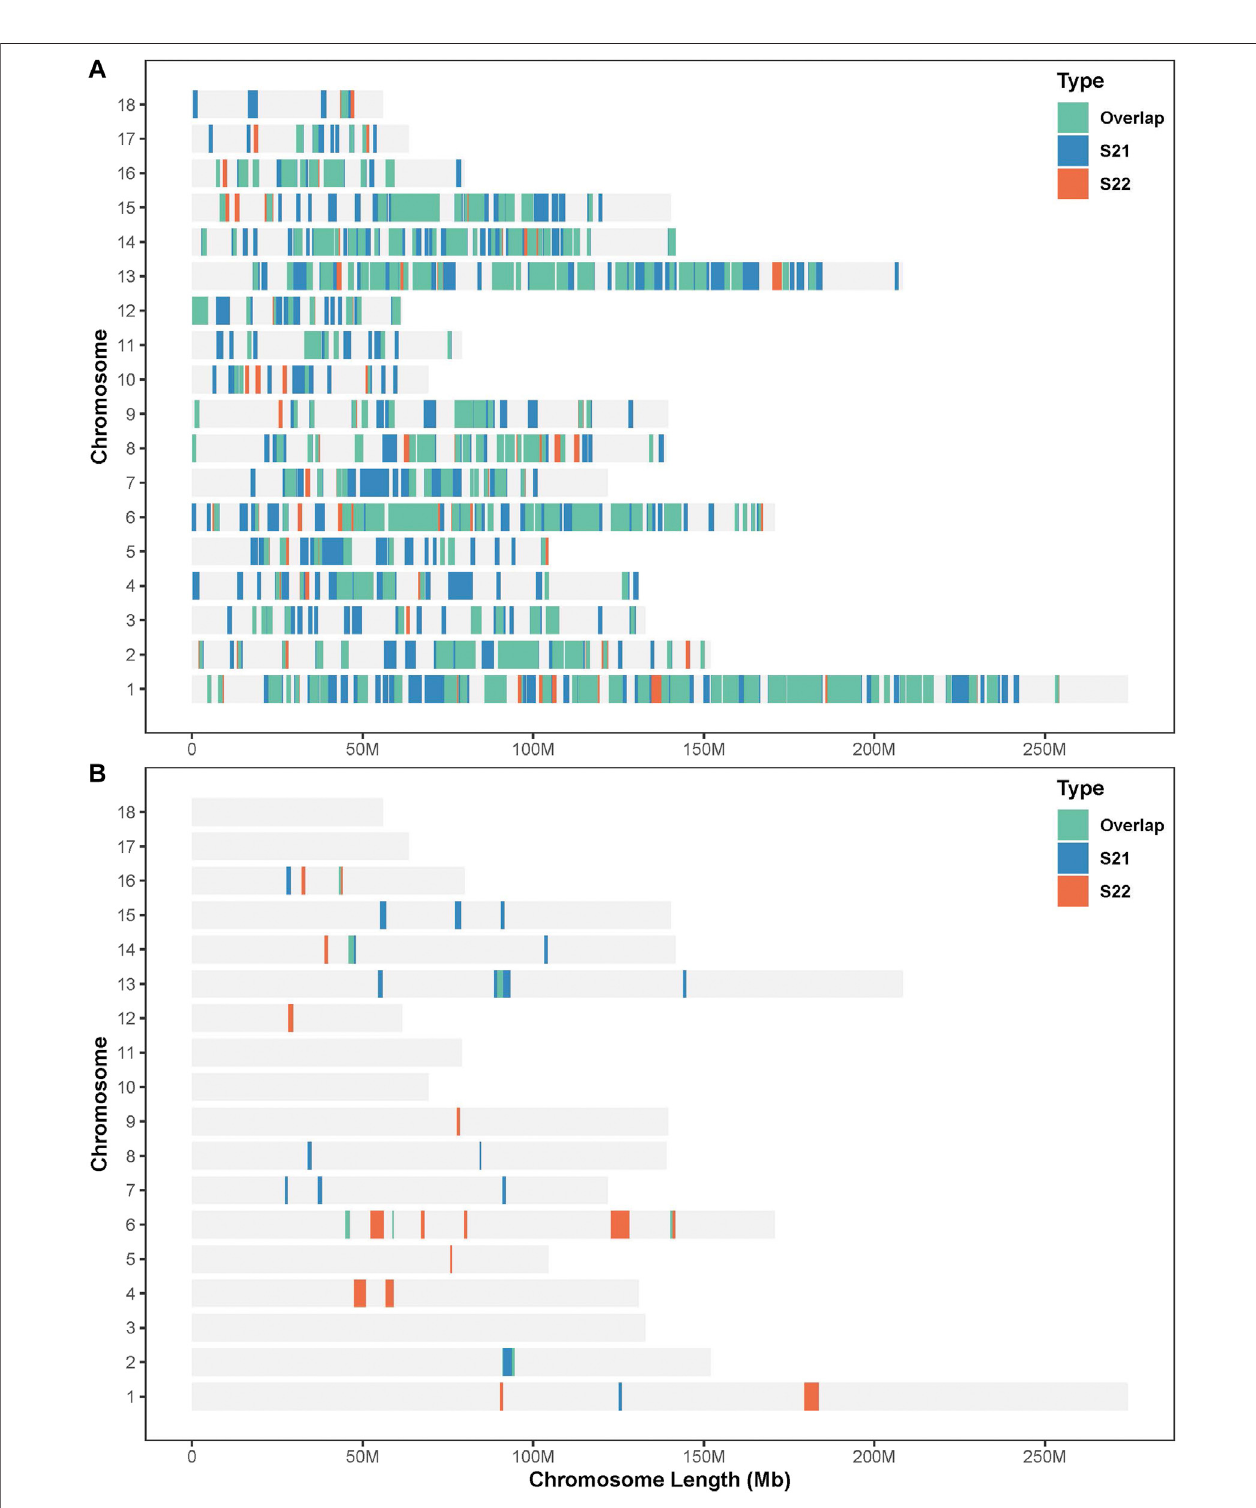
FIGURE3| DistributionoftheROHetsandROHetislandsintheautosomesoftwoDurocpopulations. (A) DistributionofROHets. (B) DistributionofROHetislands.